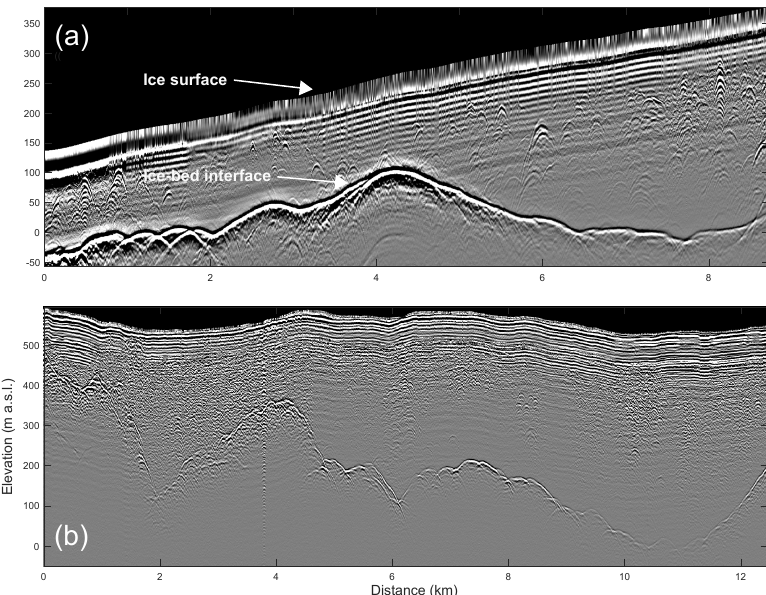
Figure 3. Examples of processed radar images collected on (a) Kongsvegen by snowmobile and (b) Holtedahlfonna by helicopter. Locations of the profiles are marked in Fig. 1 with black